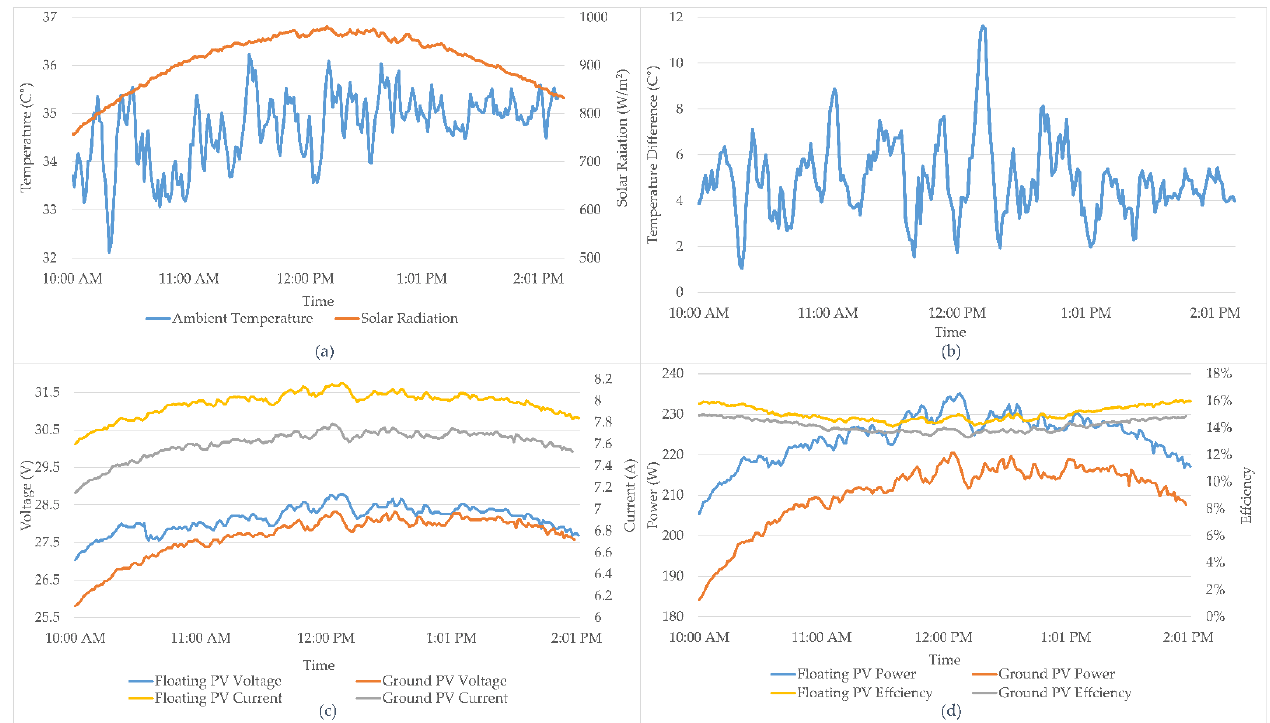
Figure 4. ( a ) Ambient temperature and solar radiation on testing day. ( b ) Difference of operating temperature between ground and floating PV panels. ( c ) Voltage and current variation for ground and floating PV panels. ( d ) Power and efficiency variation of ground and floating PV panels.